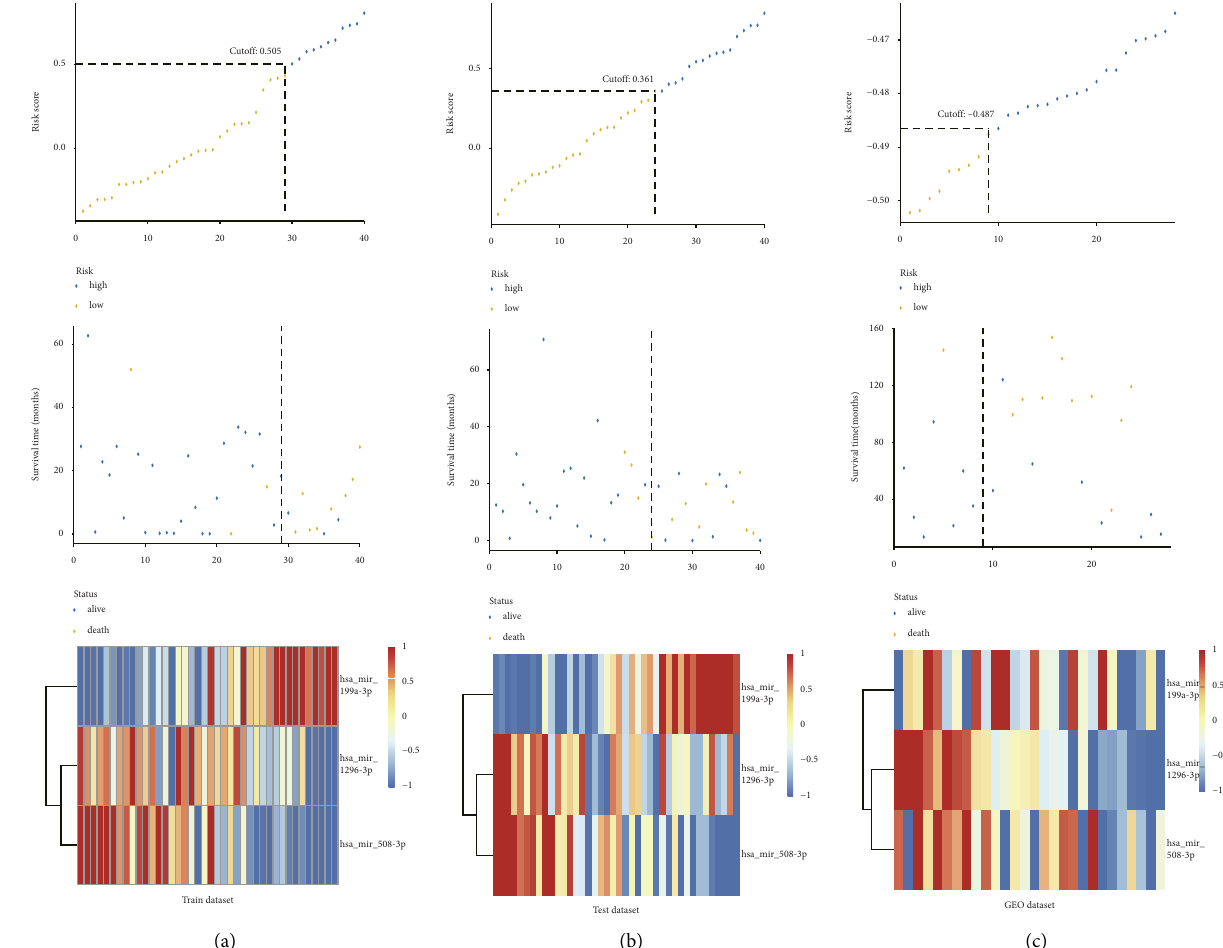
Figure 1: Risk score analysis of the training ( n � 40), testing ( n � 40) and GSE84976 datasets. (a): Te distribution of risk score, patients’ survival time and status, heatmap of 3-miRNA expression signature in training dataset. (b): Te distribution of risk score, patients’ survival time and status, heatmap of 3-miRNA expression signature in testing dataset. (c): Te distribution of risk score, patients’ survival time and status, heatmap of miRNA expression signature in GSE84976